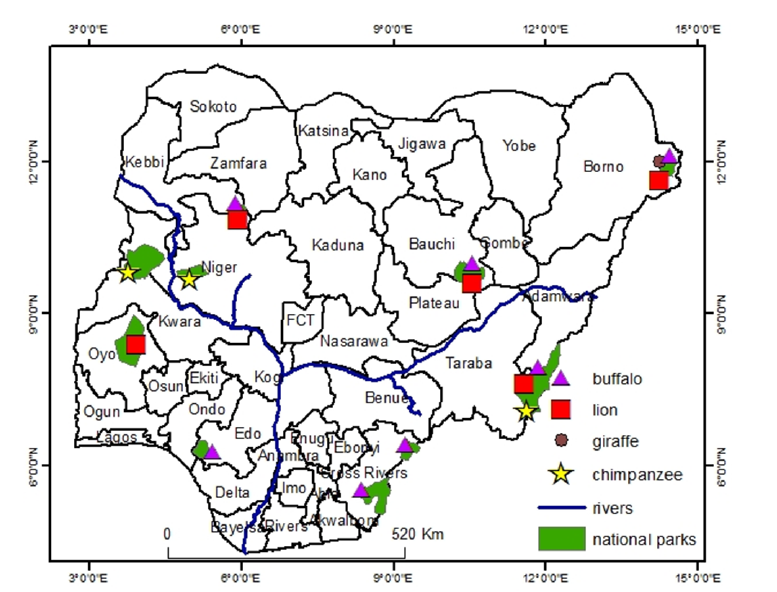
Fig. 5. Distribution of some wildlife species in Nigeria’s wildlife parks